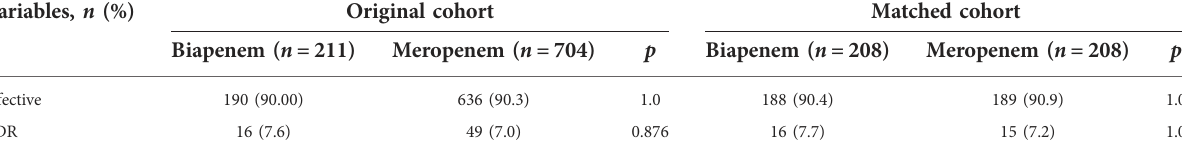
TABLE 2 Comparison of clinical outcomes and adverse reactions between Biapenem group and Meropenem group before and after matching. Variables, n (%)